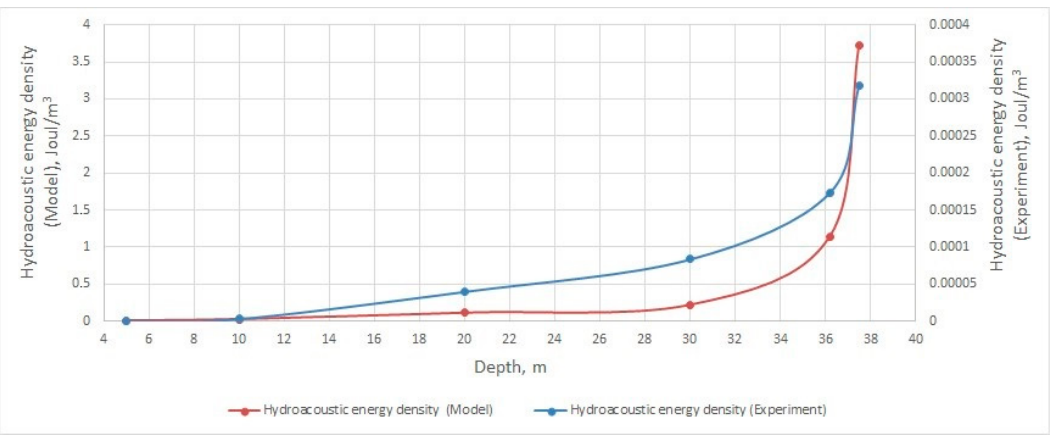
Figure 7. Graphs of the hydroacoustic energy density changes in the model calculations and experimental research.